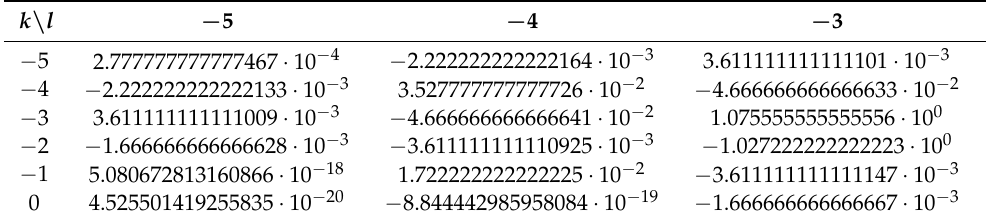
; [ 0,1 ]) evaluated up to machine ( 2,1 )